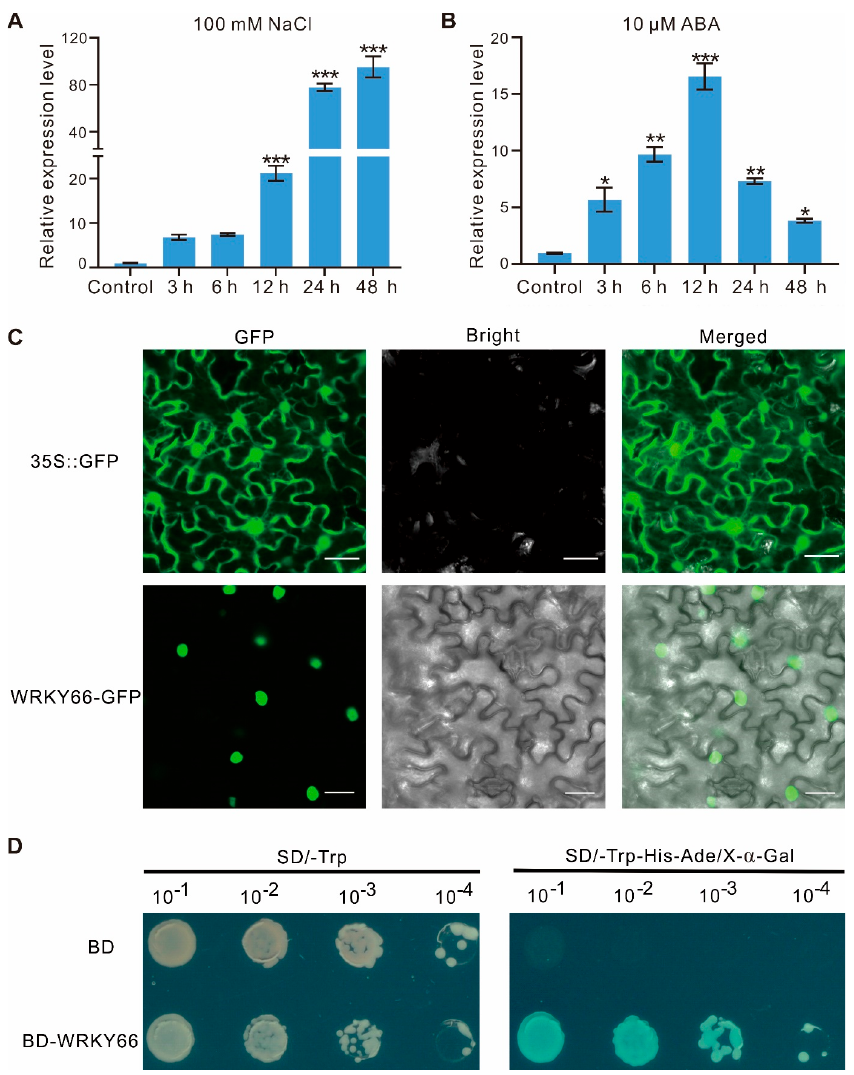
Figure 3. Expression characteristics, subcellular localization and transcription activity of AtWRKY66 . The expression levels of AtWRKY66 at different times under salt ( A ) and ABA ( B ) treatment. 10-day-old seedlings were treated with 100 mM NaCl or 10 µM ABA with the time course. After RNA extraction and reverse transcription, qRT-PCR assays were performed. Actin was used as an internal control for normalization. Error bars indicated the standard deviation (SD) on three replicates. Asterisks indicated a statistically significant difference compared with the control (* p < 0.05; ** p < 0.01; *** p < 0.001; Student’s t -test). ( C ). Subcellular localization of AtWRKY66 in N. benthamiana leaves. AtWRKY66 -GFP fusion proteins and GFP alone were each expressed transiently in leaves of N. benthamiana plants after 48 h post infiltration (hpi) and detected by confocal in the dark field for green fluorescence, white field for cell morphology and in combination, respectively. GFP, GFP fluorescence (green); Bright, bright-field; Merged, overlay of the GFP and bright-field images. Bar = 20 µm. ( D ). Identification of the transcription activation of AtWRKY66 . Yeast cells carrying pGBKT7(BD)- AtWRKY66 or a pBD empty vector (as a negative control) were streaked on SD/-Trp plates (top) or SD/-Trp-His-Ade plates supplemented with X- α -gal (bottom) for 3 day at 28 °C.